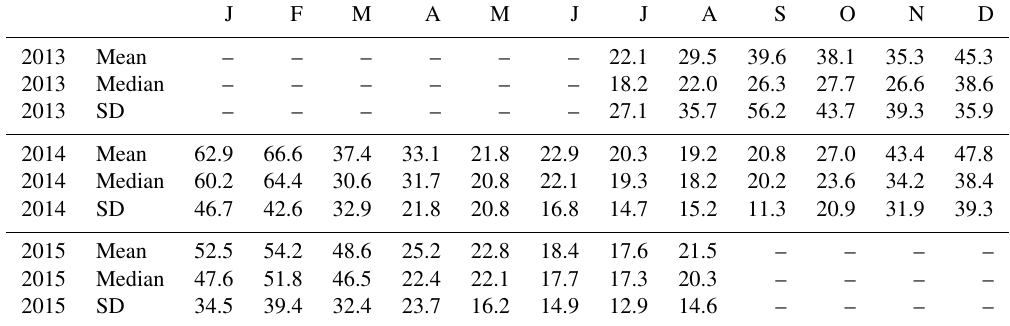
Table 2. Monthly values of mean, median and standard deviation values of FCH 4 in the centre of Łód´z in the period July 2013–August 2015 (all fluxes in nmolm − 2 s − 1 ).